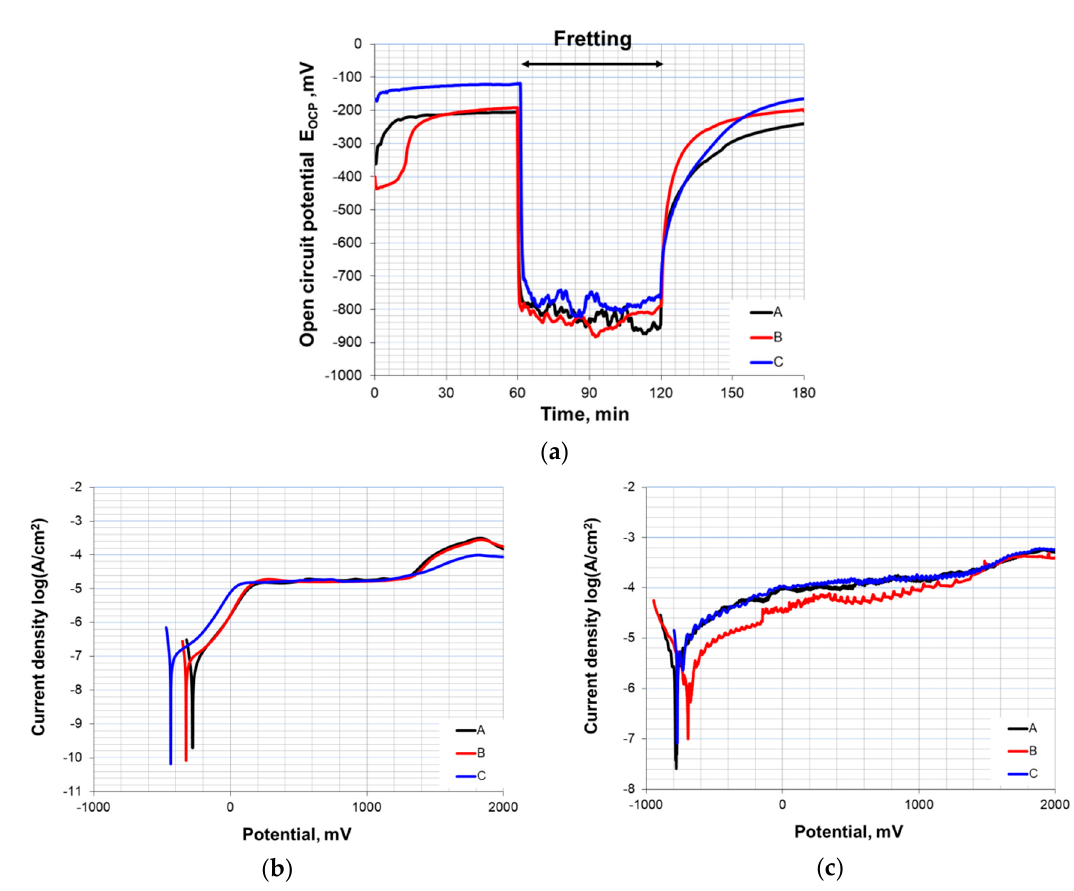
Figure 11. Electrochemical results of fretting corrosion tests: ( a ) Open circuit potential curves, ( b ) anodic polarization in static conditions, and ( c ) anodic polarization in dynamic conditions.